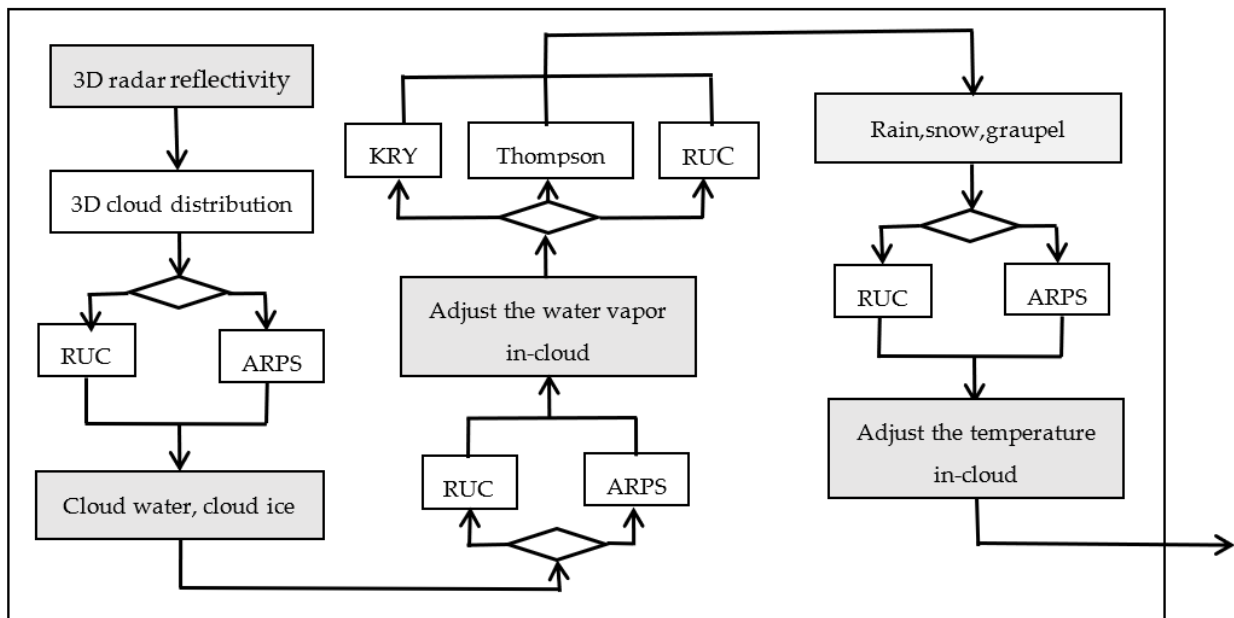
Figure 5. Flow diagram of the cloud analysis method for assimilating reflectivity.